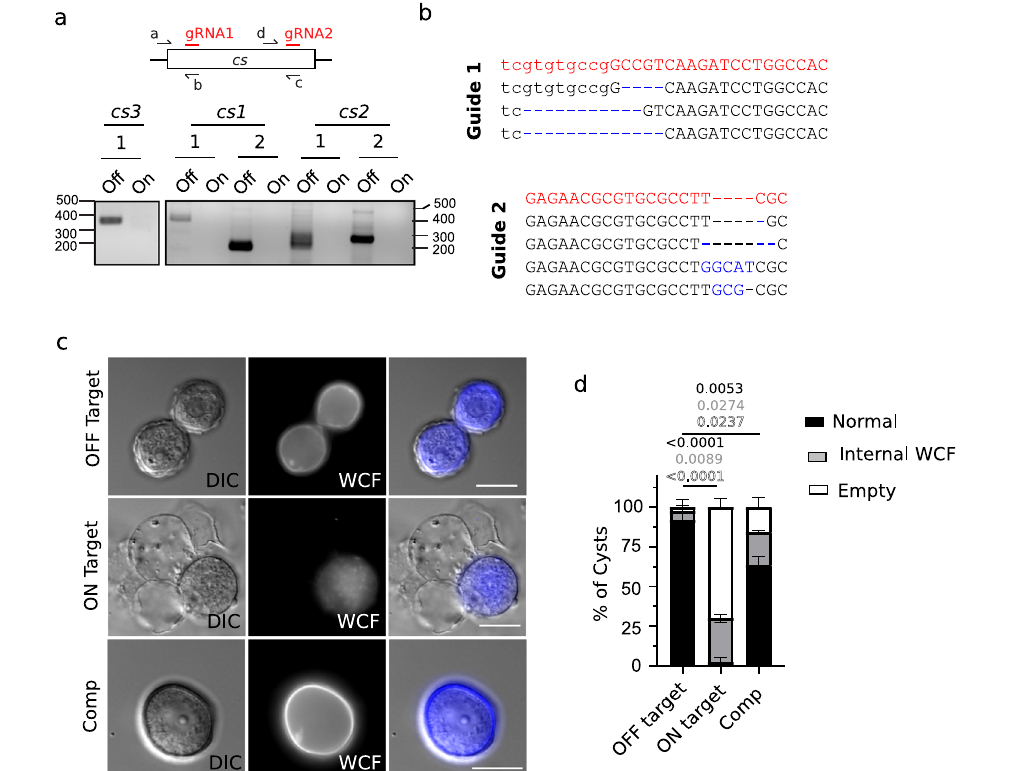
Fig. 2 | CRISPR/Cas9 allows manipulation of A. castellanii . a Disruption of genes encoding cellulose synthase 1 – 3 ( cs1-3) is observed at the population level after 2 – 3 weeks post-transfection. Reverse primers are designed to anneal at the gRNA targeting sequencing. Disappearance of the PCR product correlates with mod- i fi cation of the locus in all the alleles. Expected PCR size: cs1 : 430bp (guide 1), 200bp (guide 2). cs2 : 250bp (guide 1) 265bp (guide 2). cs3 : 320bp. Guides tar- getingmRFPwereusedasoff-targetgRNAs. b Representativesequencingresultsof cs1 upon transfection with on-target gRNAs. PCR were performed on the target sequences, cloned into a TA cloning vector and single clones were sent for